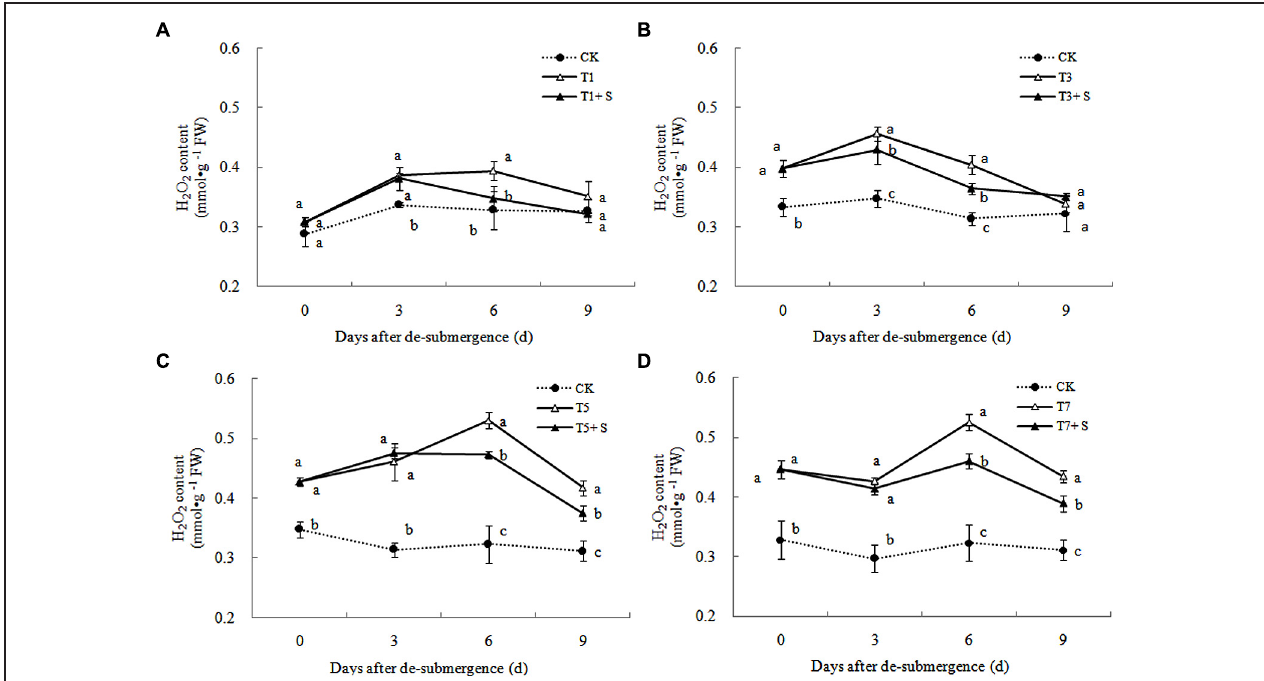
FIGURE 8 | Effects of Spd on H 2 O 2 content of rice after submergence.